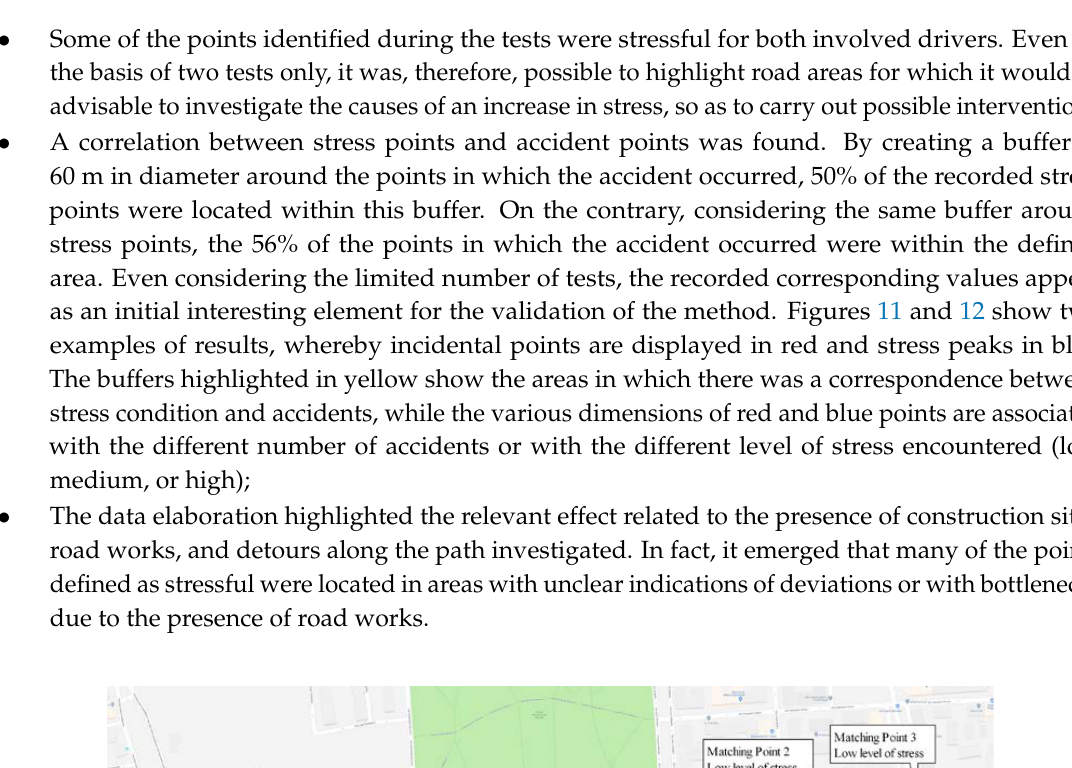
Figure 10. Location of the peak stress points (QGIS elaboration of Google Maps).